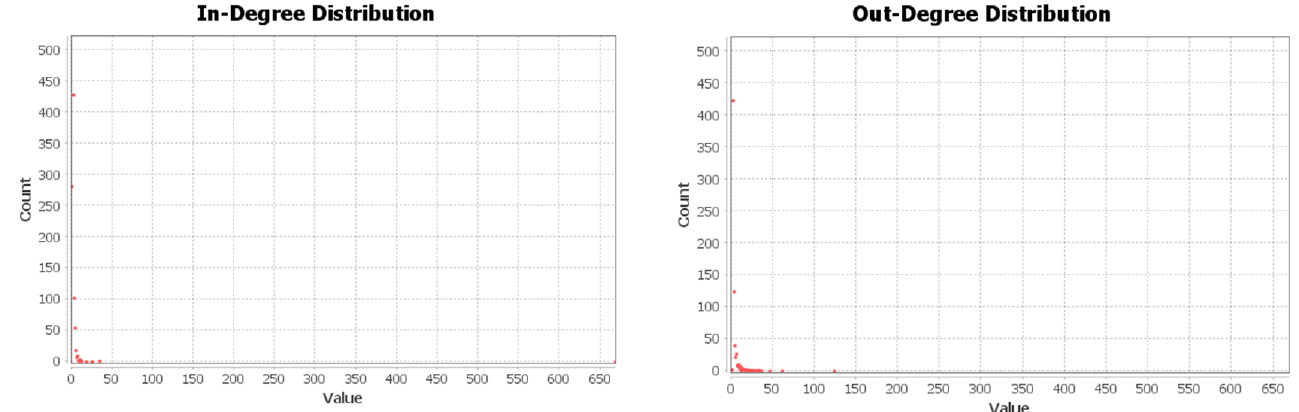
Figure 1. Distribution of in-degree and out-degree in the homogeneous user interaction network.